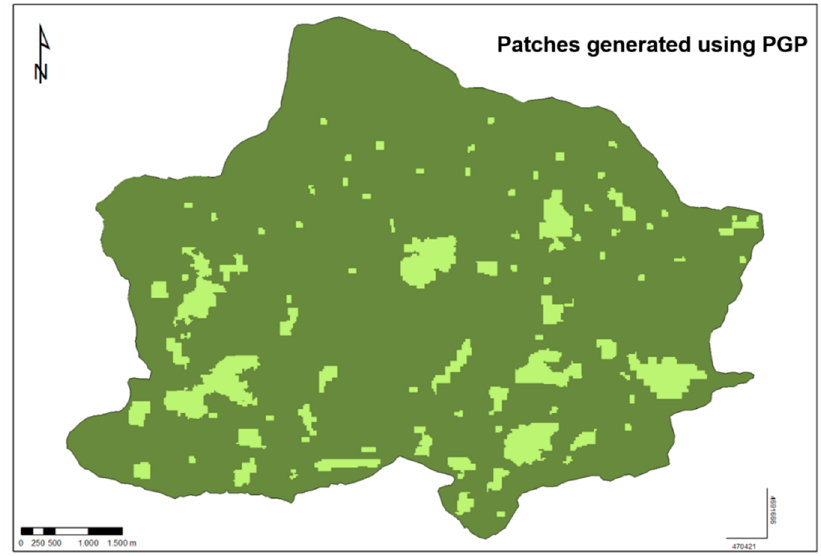
Figure 7. Agricultural patches generated using PGP algorithm.